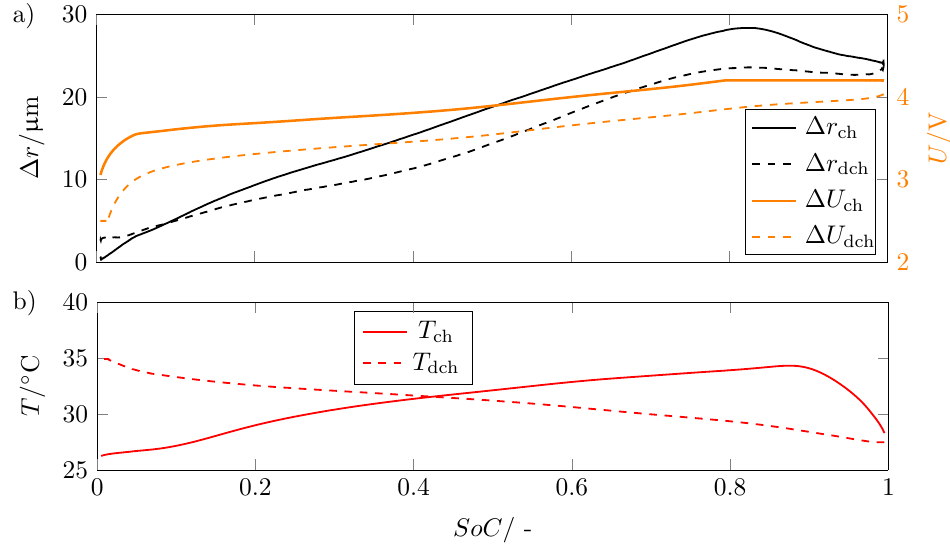
Figure 7. ( a ) Change in radius ∆ r in µ m for charge and discharge and the associated voltage U in V versus State of Charge SoC showing the hysteresis between charging and discharging; ( b ) temperature curve T in ◦ C during charging and discharging versus the state of charge